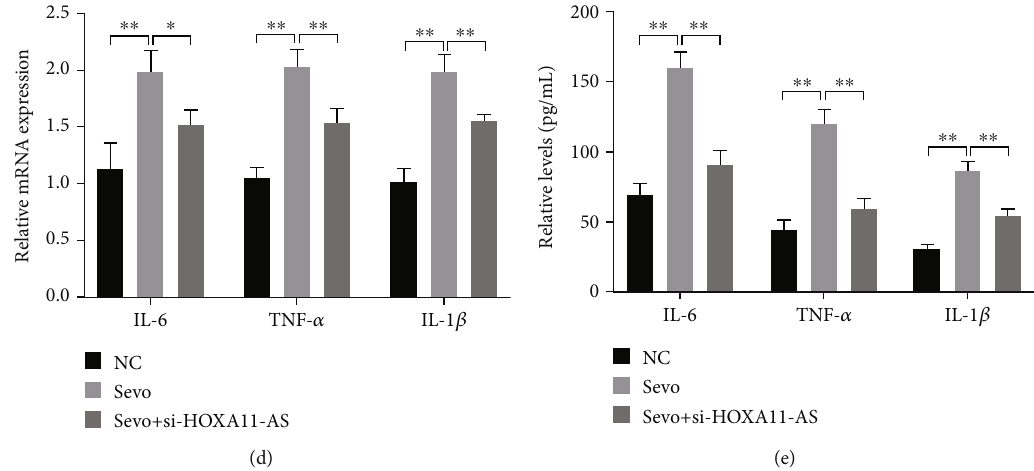
Figure 2: Inhibition of HOXA11-AS alleviates sevo fl urane-induced neuronal apoptosis and in fl ammatory response in vitro. (a, d) RT-qPCR for detection of HOXA11-AS and mRNA expression of in fl ammatory factors. (b) TUNEL staining to detect neuronal apoptosis. (c) Western blot detects apoptosis-related protein expression. (e) ELISA detects the in fl ammatory factors levels. ∗∗ P < 0 : 01 .